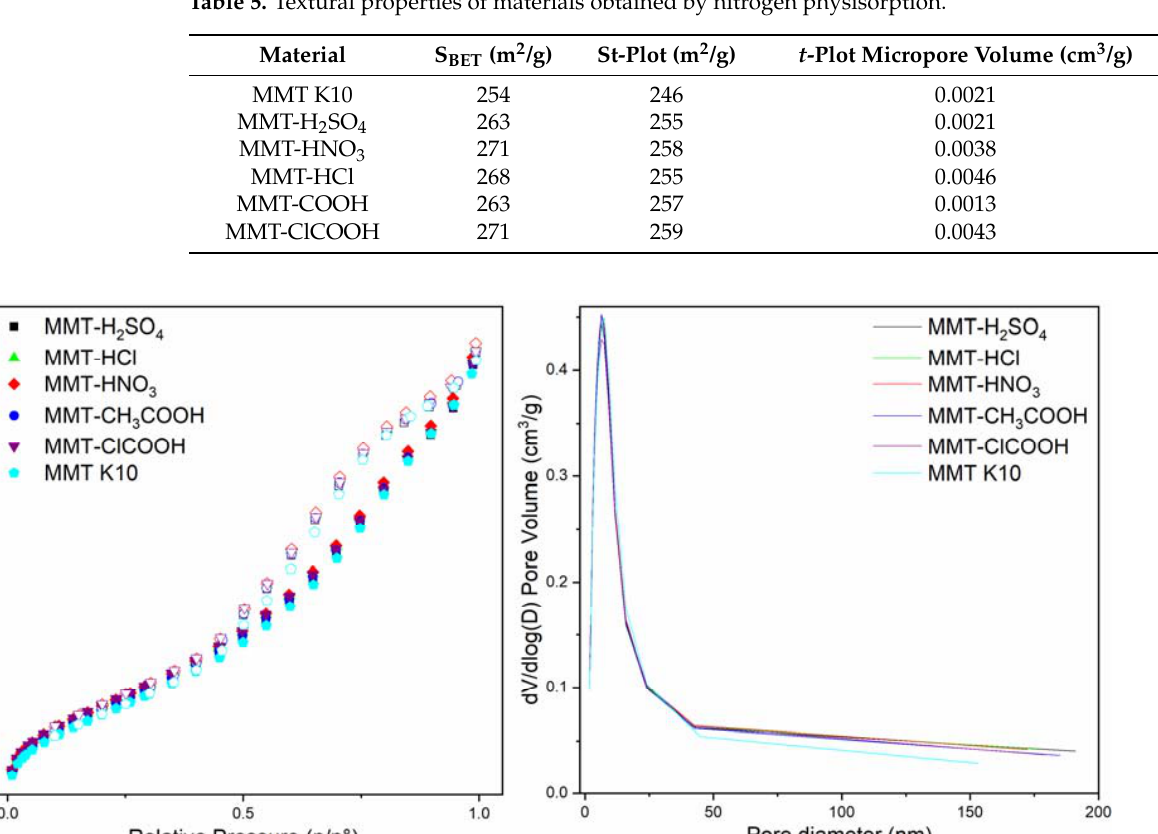
Table 5. Textural properties of materials obtained by nitrogen physisorption.